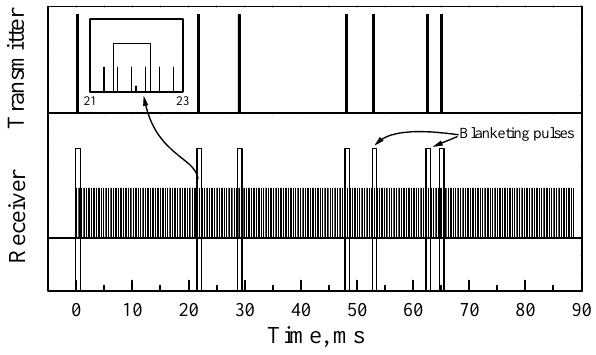
Fig. 1. Transmit pulse sequence and receiver sampling times used in SuperDARN